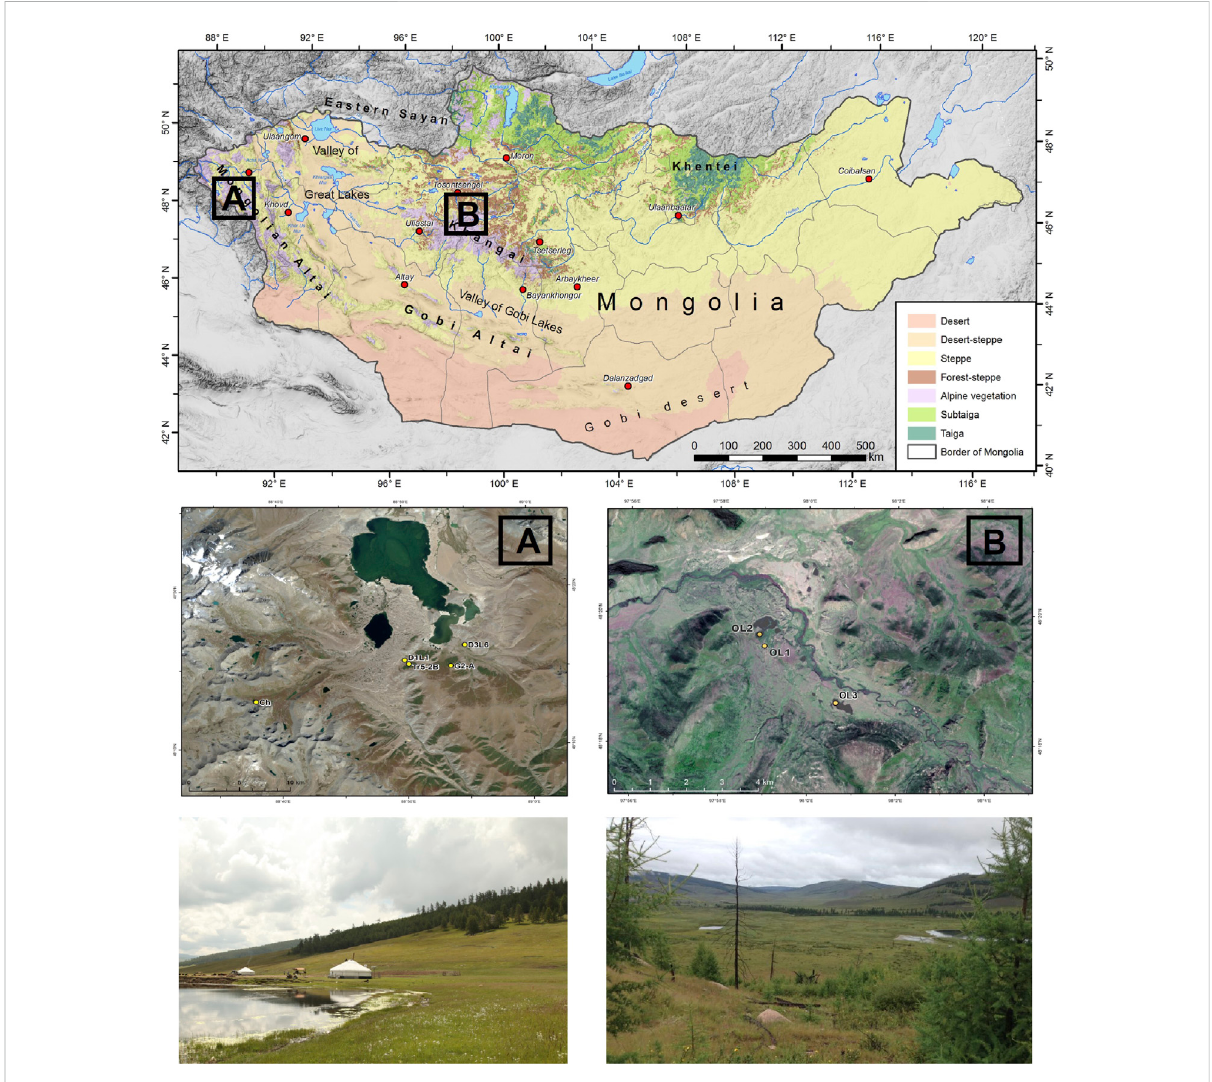
FIGURE 1 Overview map of Mongolia with locations of study areas Altai Tavan Bogd National Park (A) and Tarvagatai Nuruu National Park (B) (modi fi ed from Klinge et al., 2021), locations of studied sites within both study areas and photos of the landscape were taken by H. Behling in 2016 and 2018..